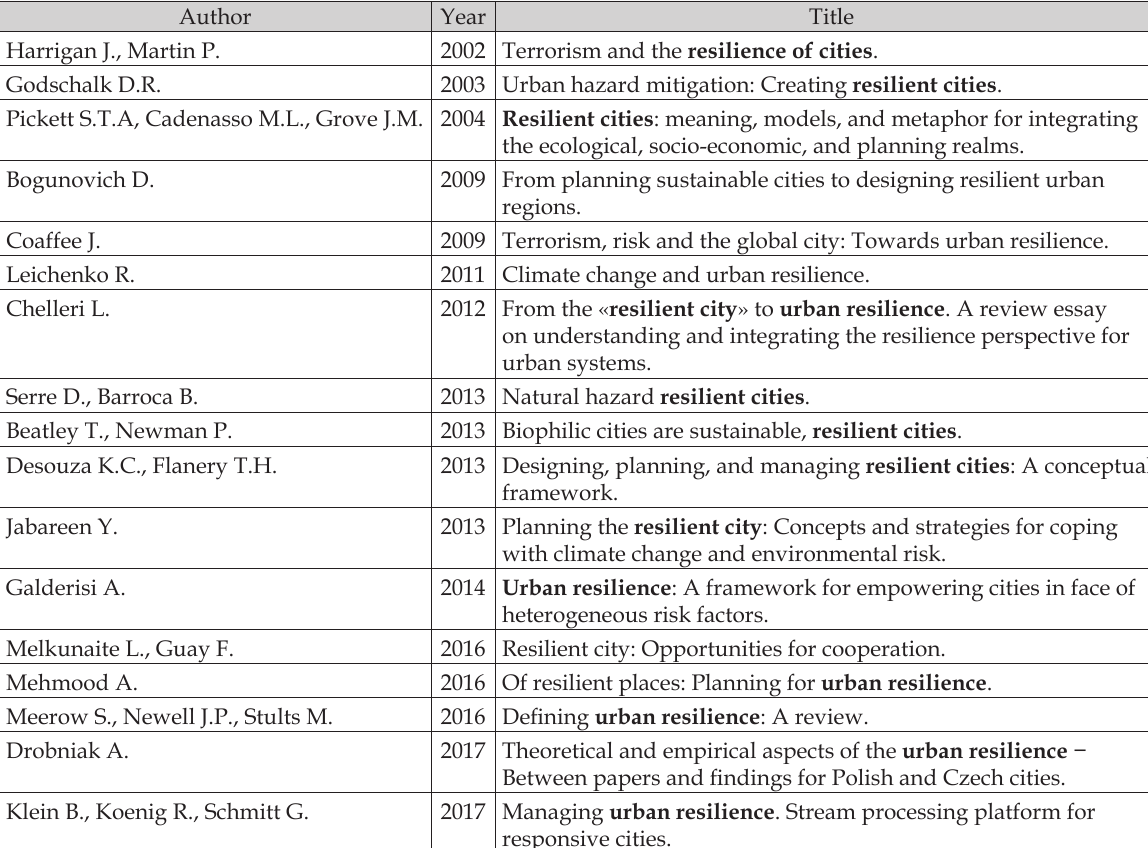
Table 2. Selected publications on the resilient city and city